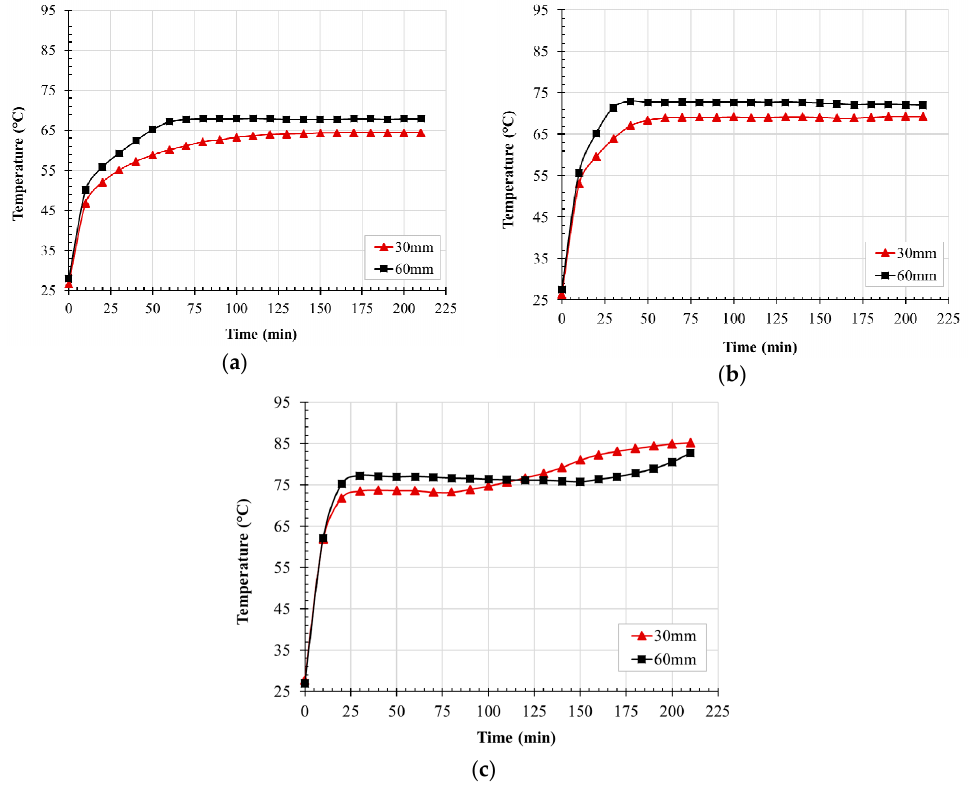
Figure 10. Heat sink surface temperature of RT58 for different thickness at power ratings ( a ) 1.0 W, ( b ) 1.5 W and ( c ) 2.0 W.